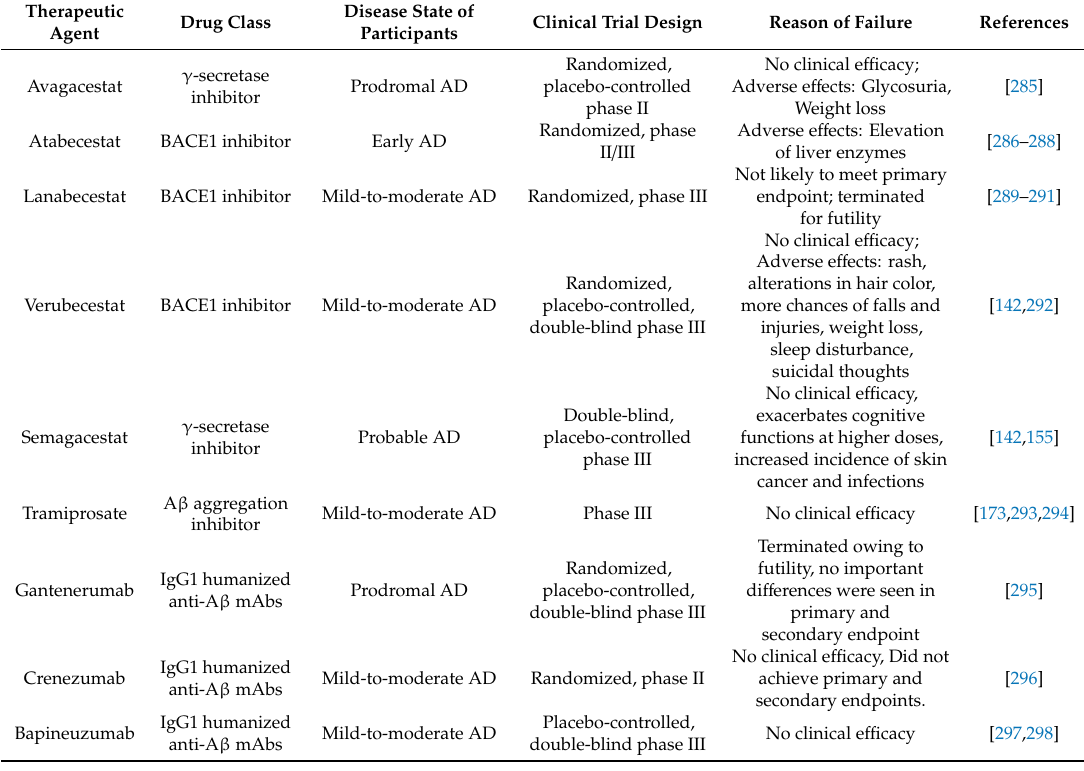
Table 1. Major failed clinical trials of anti-A β therapeutics to treat Alzheimer’s disease.